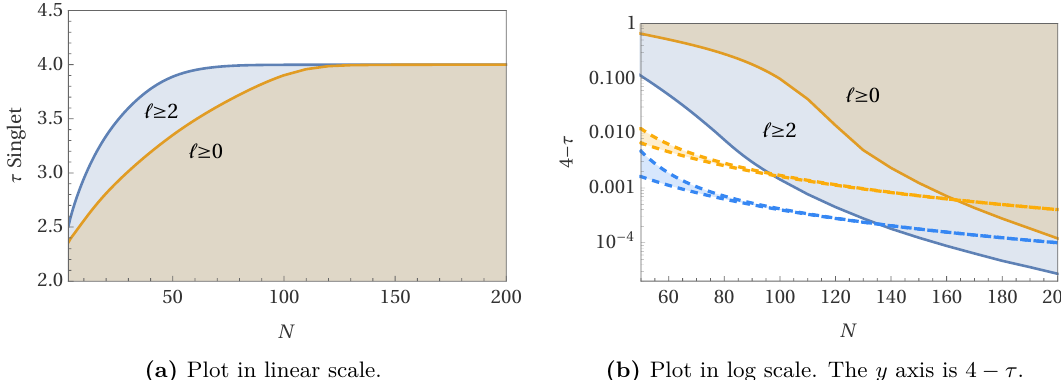
Figure 1. Bounds obtained by gapping the twist of all singlets (in yellow) and by gapping the twist of only the singlets with spin ‘ ≥ 2 (in blue). The shaded region is allowed. These plots have been obtained with Λ = 27 . The dashed lines correspond to the supergravity prediction for ‘ = 0 (yellow) and ‘ = 2 (blue), which can be found in (5.13), with λ ∈ [ c/ 10 , c ]